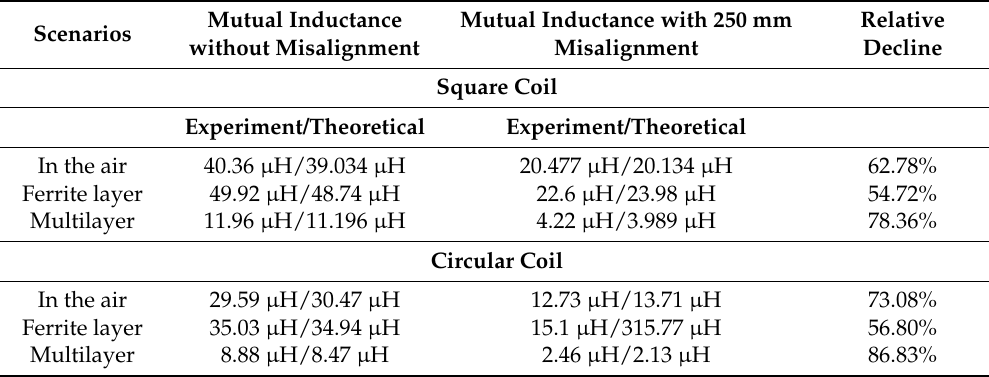
Table 5. Mutual inductance comparison with lateral misalignment.